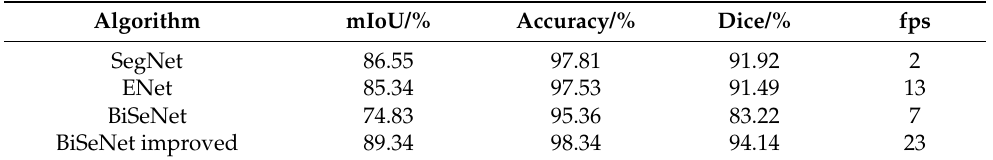
Table 2. Comparison of evaluation indexes of different networks on underground mine slope